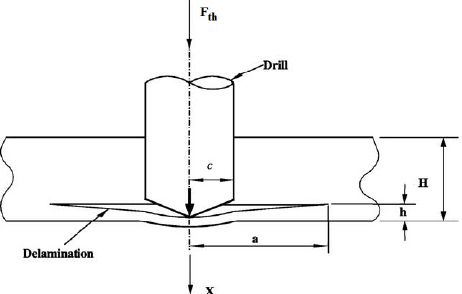
Figure 2. The schematic of delamination for unsup- ported